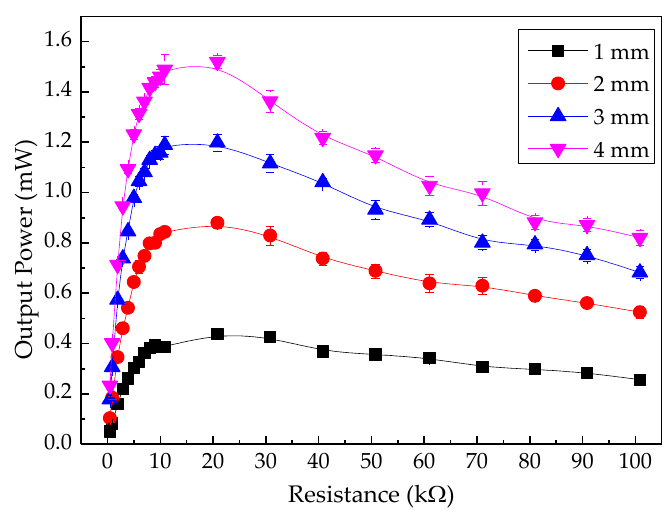
Figure 9. Output power of TEH test bench at various gap widths from 1 mm to 4 mm.